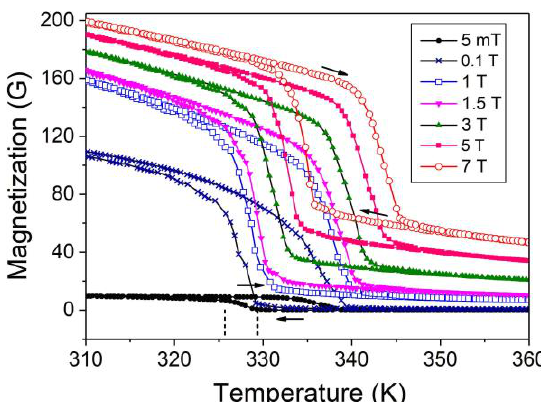
Figure 1. Temperature dependences of magnetization of Ni 50 Mn 17.5 Ga 25 Cu 7.5 alloy measured for different values of external magnetic field. Vertical dashed lines point to the martensite start and martensite finish temperatures used for theoretical modeling of experimental dependences .